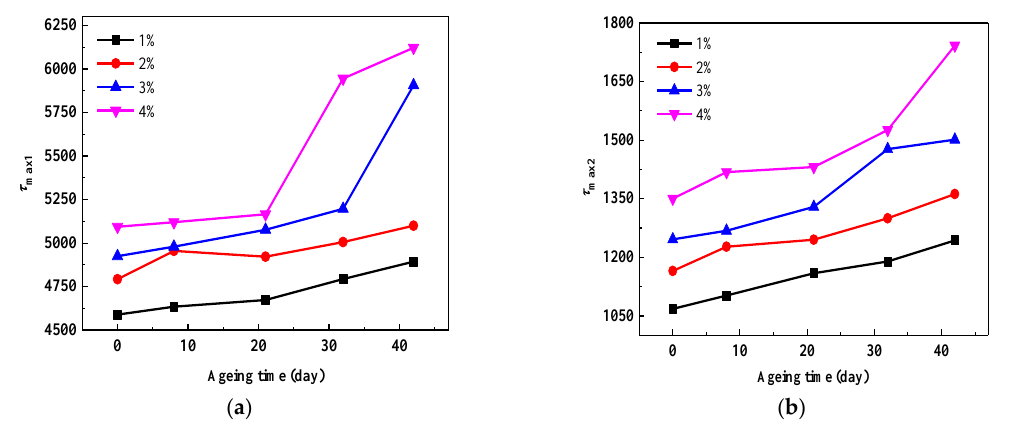
Figure 6. Maximum and second maximum time constants with different ageing times. ( a ) τ max1 ; ( b ) τ max2 .